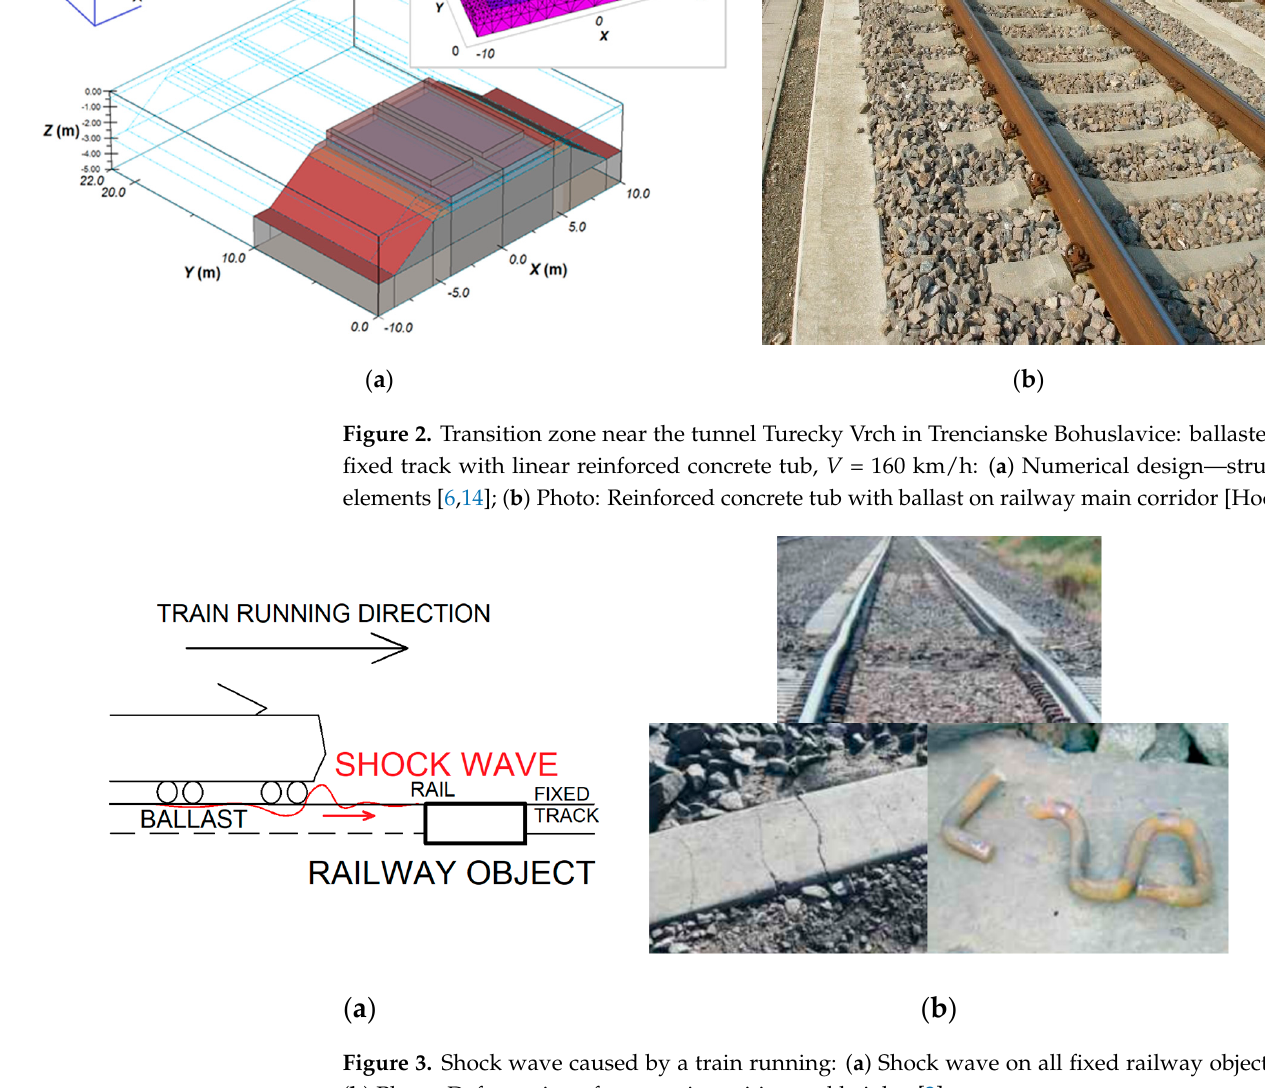
Figure 3. Shock wave caused by a train running: ( a ) Shock wave on all fixed railway objects [13]; ( b ) Photo: Deformation of geometric position and heights [2].